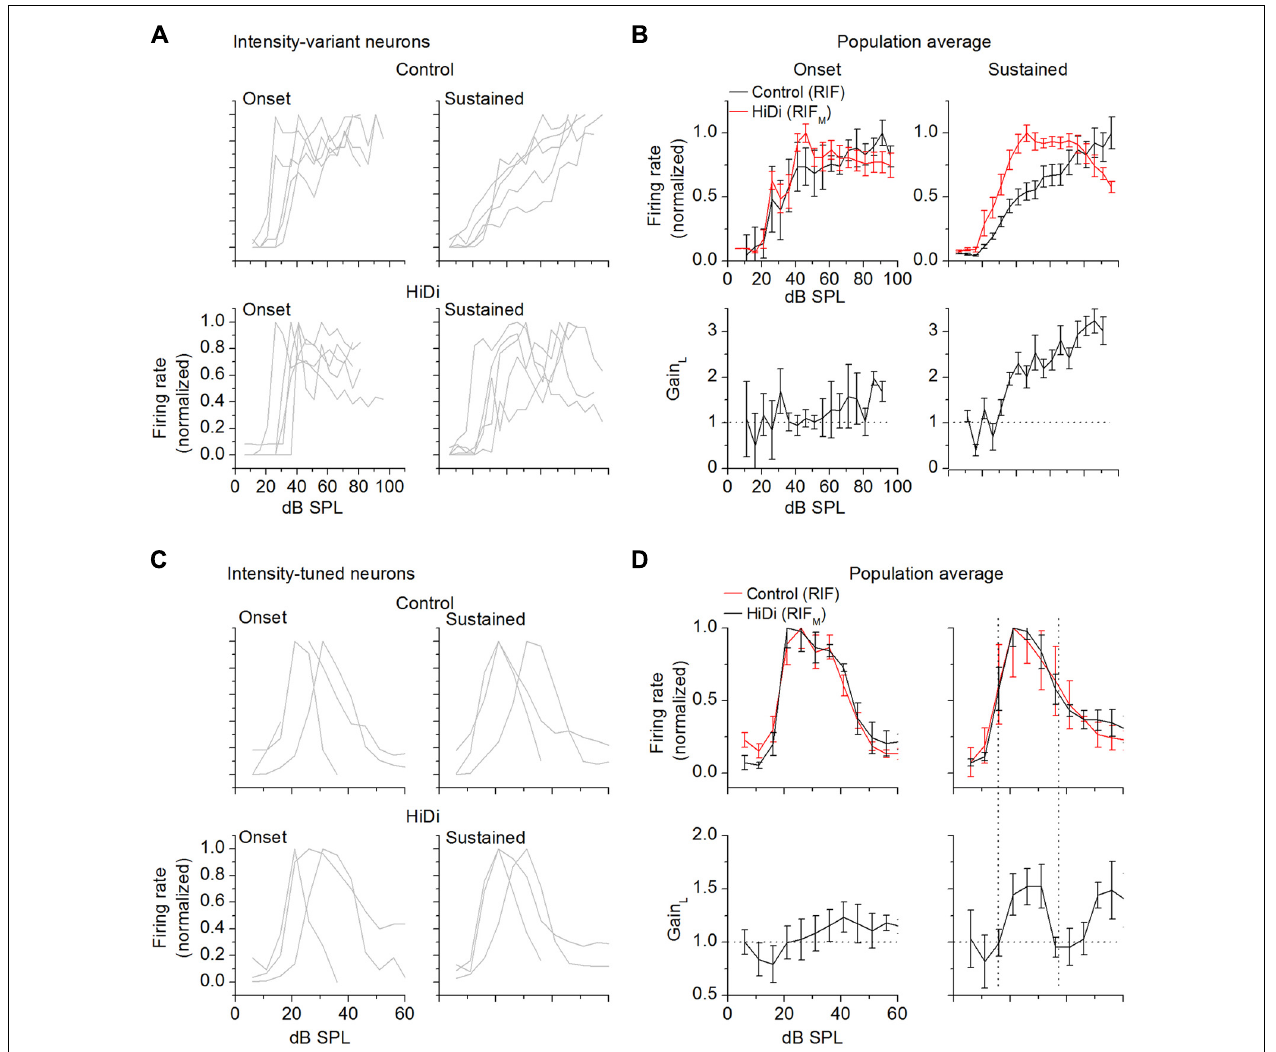
averaged across cells. Local circuit gain does not increase during the onset portion ( F 4,44 = 1.22; p = 0.31), but increases during the sustained response ( F 4,44 = 9.72; p < 10 − 5 ). (C,D) Intensity-tuned neurons. (C) Onset and sustained responses in control (top) and HiDi (bottom) for three cells with different tuning widths. (D) Population averages. 14 cells. Mean and SD. Since the HiDi and control functions were normalized, their peaks overlap. A slight increase in gain occurs during the onset portion of the tone ( F 4,52 = 2.74; p = 0.038). Strong local circuit activation during the sustained portion of the tone occurs during the tuned region (vertical dotted lines). Gain L was measured prior to normalization of the control and HiDi RIFs and